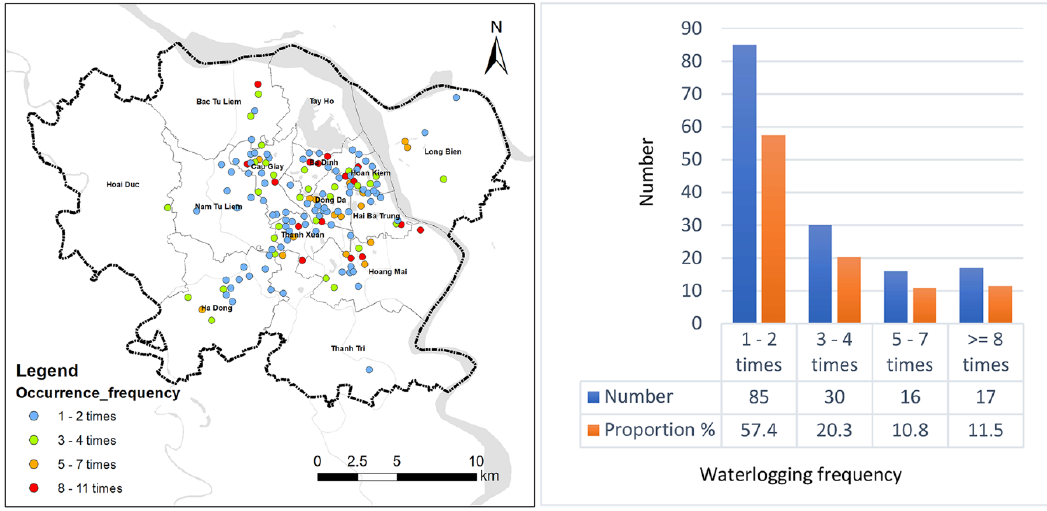
Figure 5. Waterlogging occurrence frequencies caused by rainstorms in the period 2012–2018.